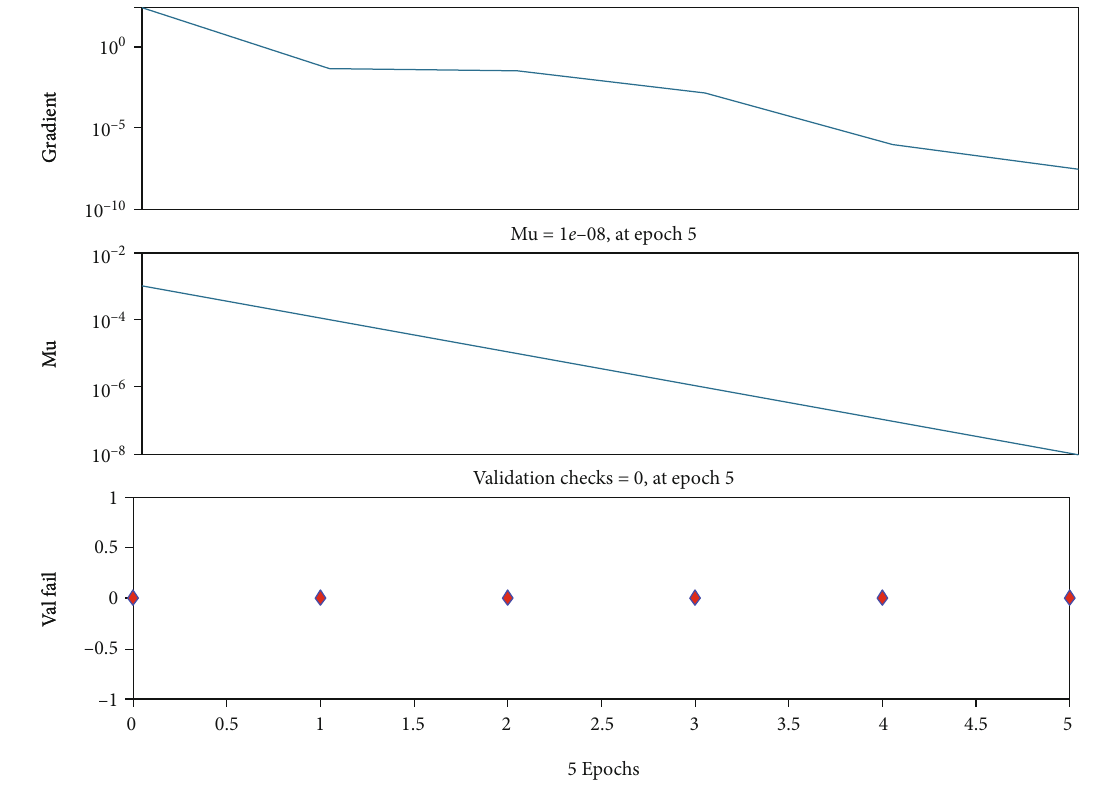
Figure 16: Training data of the DNN-based fuel fl ow